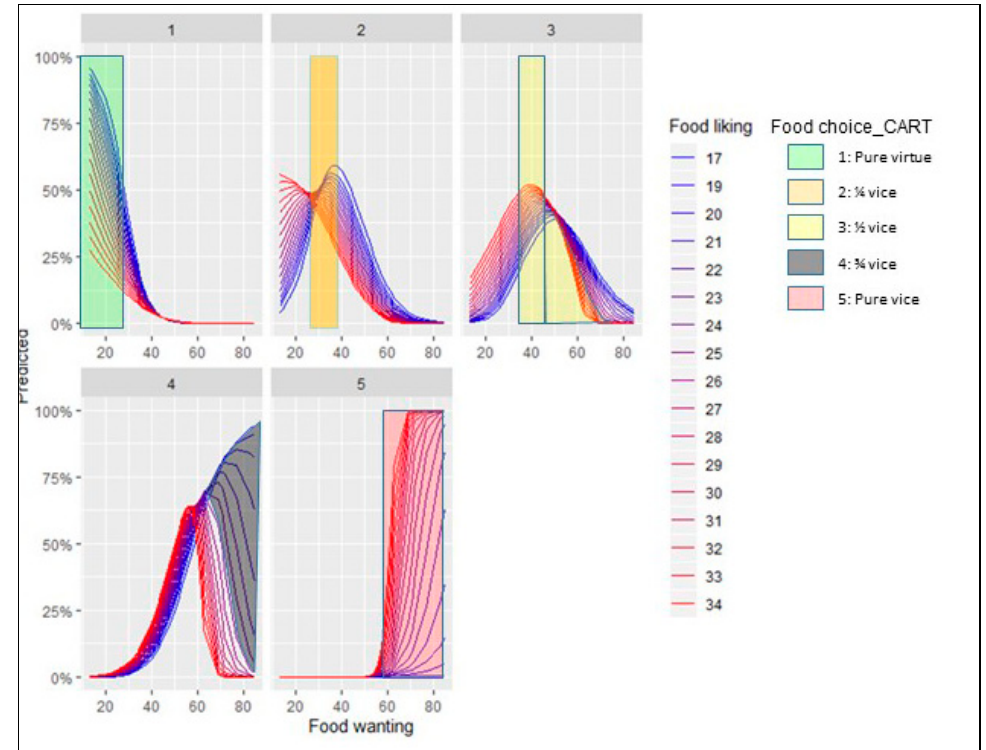
Figure 10. Marginal effects and Classification and Regression Tree (CART) of the interaction term (Food liking*Food wanting). Two-option set.